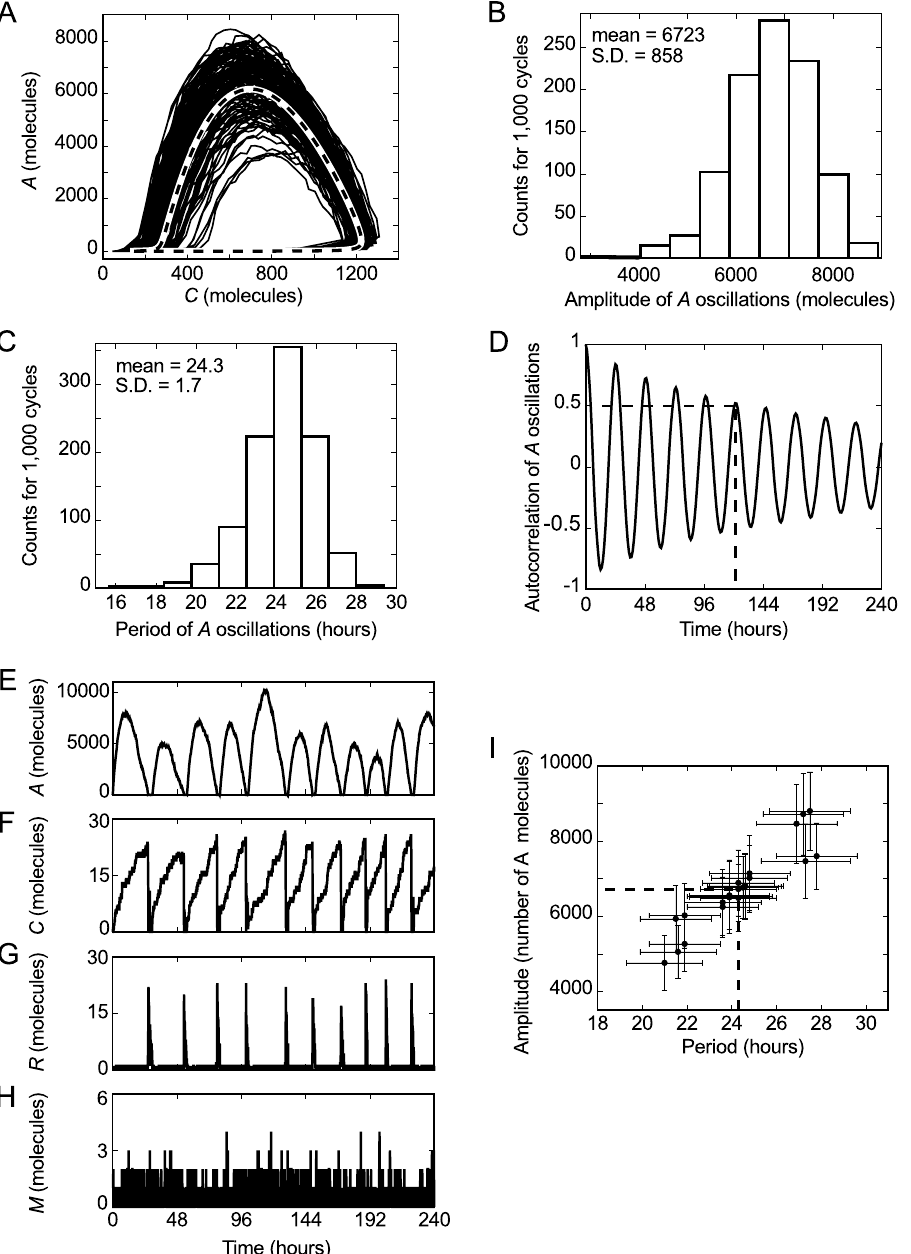
Figure 4. Model robustness to noise. A. Stochastic and deterministic phase plane defined by C and A . The general shape of the curves is the same in both cases, but the deterministic curve (dashed line) is well defined because the oscillations are identical. In contrast, the stochastic curve (solid line) spreads around the deterministic one. B, C. Amplitude and period histograms of the stochastic simulation of A , respectively. D. Autocorrelation of the stochastic oscillations in the number of A molecules. The half-life of the autocorrelation is about 120 hours (intersection of dashed lines). E – H. Model robustness to intrinsic noise when the number of molecules is low. The changed rates are k 4 ~ 1000 hour { 1 , k 5 ~ 5000 hour { 1 , k 7 ~ 25 : 5 molecules { 1 hour { 1 , k 8 ~ 132 : 6 hour { 1 and k 9 ~ 1 molecules hour { 1 . In particular, we multiplied the rates k 4 and k 5 by 100 to obtain a low number of M molecules. Simultaneously, we multiplied the rates k 7 and k 8 , and divided the rate k 9 by 51 to obtain a low number of R and C molecules. The initial conditions are G a 0 ~ 1 and G 0 ~ M 0 ~ A 0 ~ R 0 ~ C 0 ~ 0 molecules. The mean value of M is 0.48 molecules. I. Model robustness to extrinsic noise. Scatter plot of amplitude versus period that shows the robustness of the model to parameter variation (data is presented in Table S1). Two stochastic simulations were performed for each parameter in which the value was increased and decreased by 15%. The x and y coordinates of each data point correspond to the mean values of the period and amplitude, respectively. The horizontal and vertical error bars are the standard deviation of the period and amplitude, respectively. The intersection between dashed lines shows the point obtained without changing the value of any rate (Figs. 4B and 4C). ( B , C , D and each data point in I were calculated for 1,000 successive cycles. We assumed that a cycle occurs if the number of proteins A increases to 1,000 molecules and then decreases to 700 molecules. The amplitude was calculated as the greatest number of A molecules in each cycle. The period was calculated as the time interval that it takes the number of proteins A to reach 1,000 molecules for the first time in two successive cycles.)